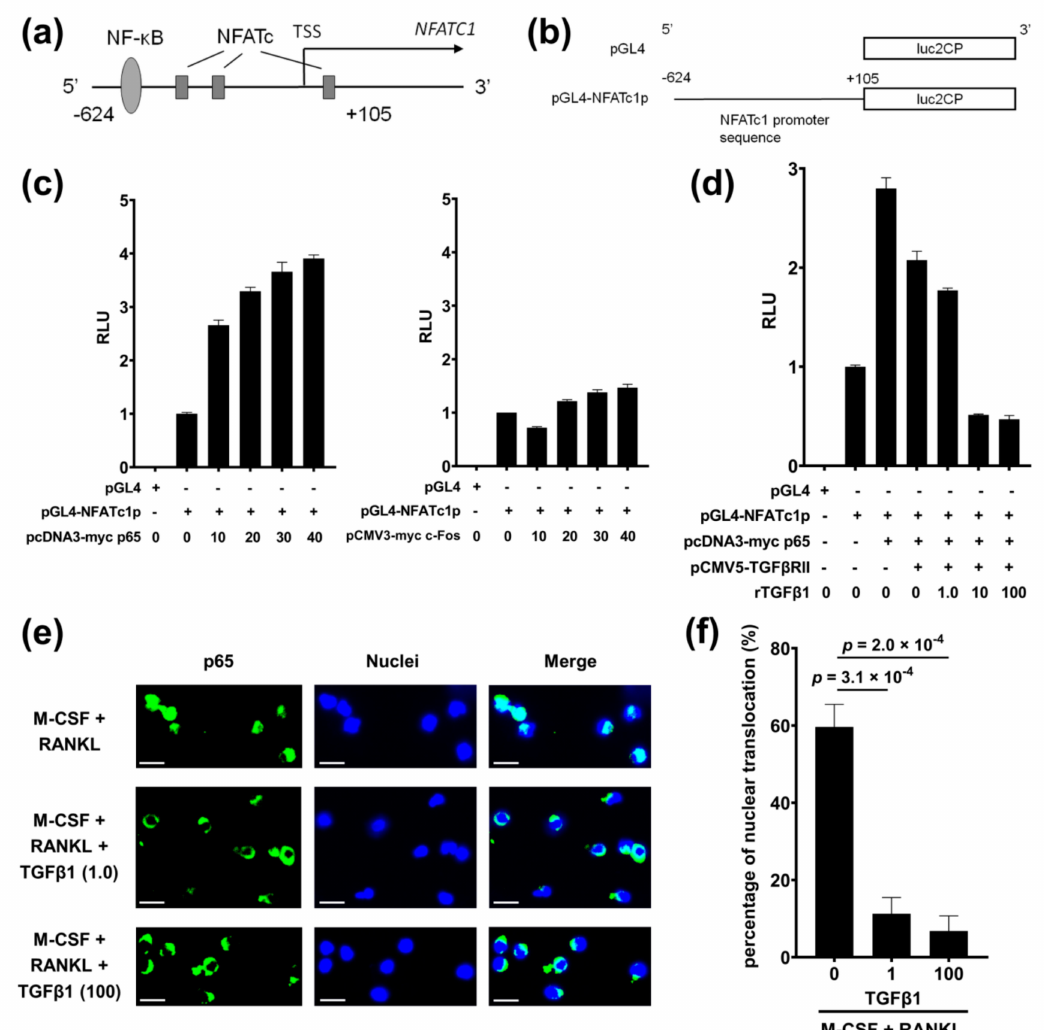
Figure 5. Inhibitory e ff ect of TGF β 1 on NFATc1 promoter activity and p65 nuclear translocation induced by RANKL. ( a ) Schematic drawing of NFATc and NF- κ B-binding motifs on the − 624 /+ 105 regions of the human NFATC1 gene. We identified the binding motif sequences (score > 10 points) on these regions, using the JASPAR database (jaspar2014.gnereg.net). ( b ) Schematic drawing of pGL4-basic plasmid (upper) and a luciferase (luc2CP)-linked NFATc1 promoter sequence containing pGL4 plasmid (pGL4-NFATc1p) (bottom). ( c ) Human embryonic kidney (HEK) 293T cells (1.0 × 10 5 cells / well in a 12-well plate) were transfected with the indicated plasmids (pGL4-basic plasmid, 200 ng; reporter plasmid (pGL4-NFATc1p), 200 ng; pcDNA3-myc p65, 0–40 ng; pCMV3-myc c-Fos, 0–40 ng; and mock plasmid (pcDNA3 vector)). ( d ) HEK293T cells were transfected with the indicated plasmids (pGL4-basic plasmid, 200 ng; reporter plasmid (pGL4-NFATc1p), 200 ng; pcDNA3-myc p65, 40 ng; pCMV5-TGF β RII, 100 ng; and mock plasmid (pcDNA3 vector)). After transfection, recombinant TGF β 1 (rTGF β 1; 0–100 ng / mL) were added to the culture for 4–6 h prior to lysis. ( e , f ) Immunofluorescence analysis and quantitative analysis of p65 nuclear translocation induced by RANKL stimulation. TGF β 1 significantly abrogated RANKL-induced nuclear translocation of p65 in a dose-dependent manner. Representative microphotographs are shown. Scale bar = 20 µ m. The data are presented as the mean ± standard